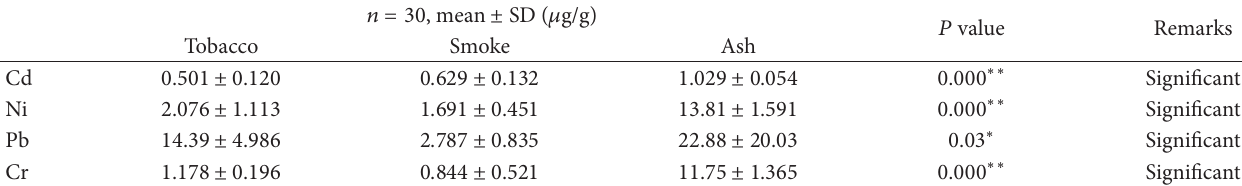
Table 4: Analysis of variance (ANOVA) for local cigarette brands in tobacco, smoke, and ash. 𝑛 = 30 , mean ± SD ( 𝜇 g/g)